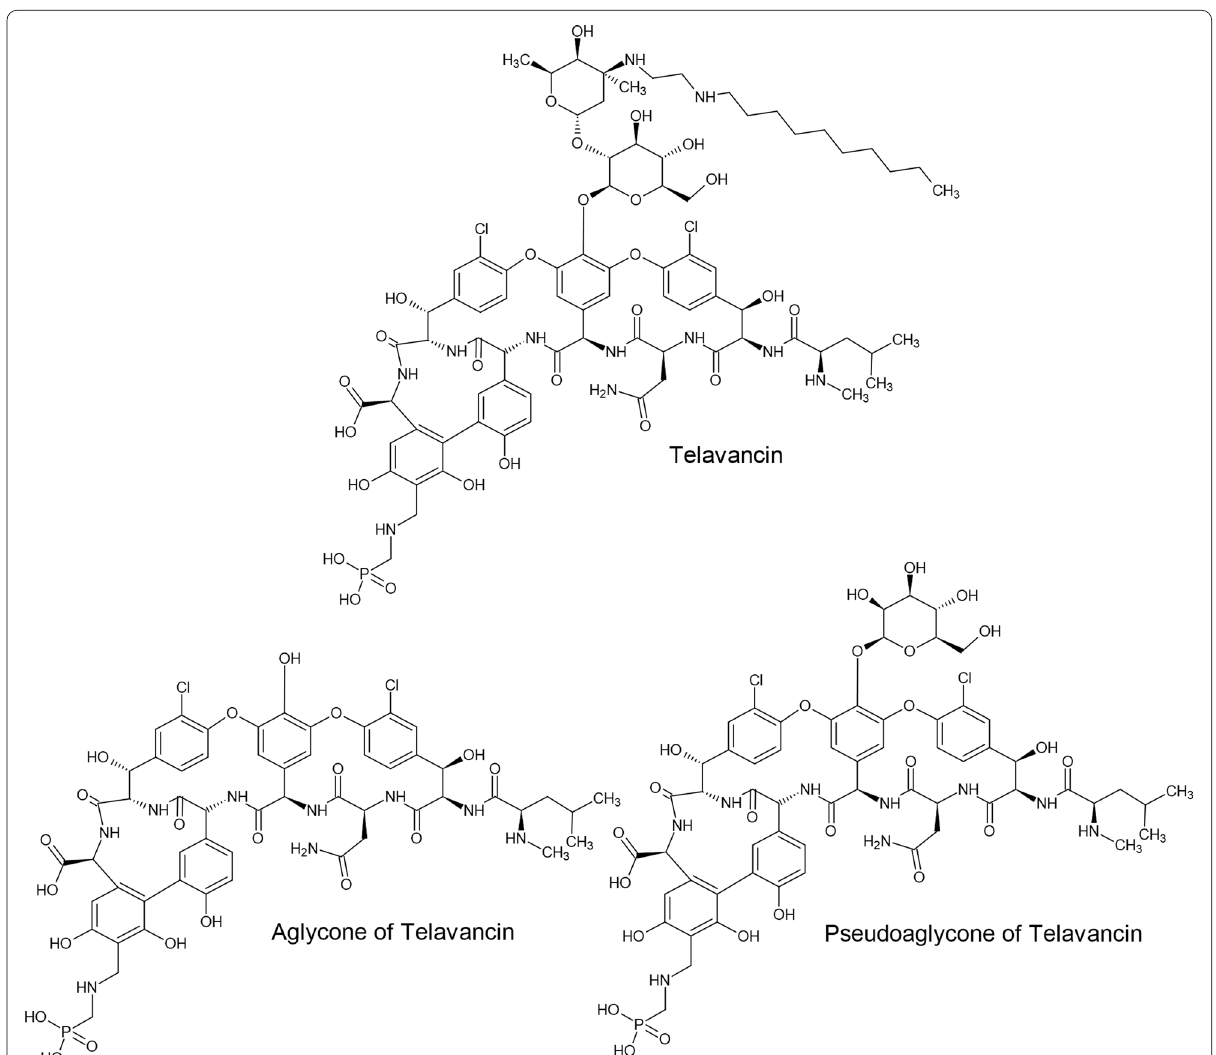
Fig. 6 Structures of telavancin and its pseudoaglycone and aglycone degradation products